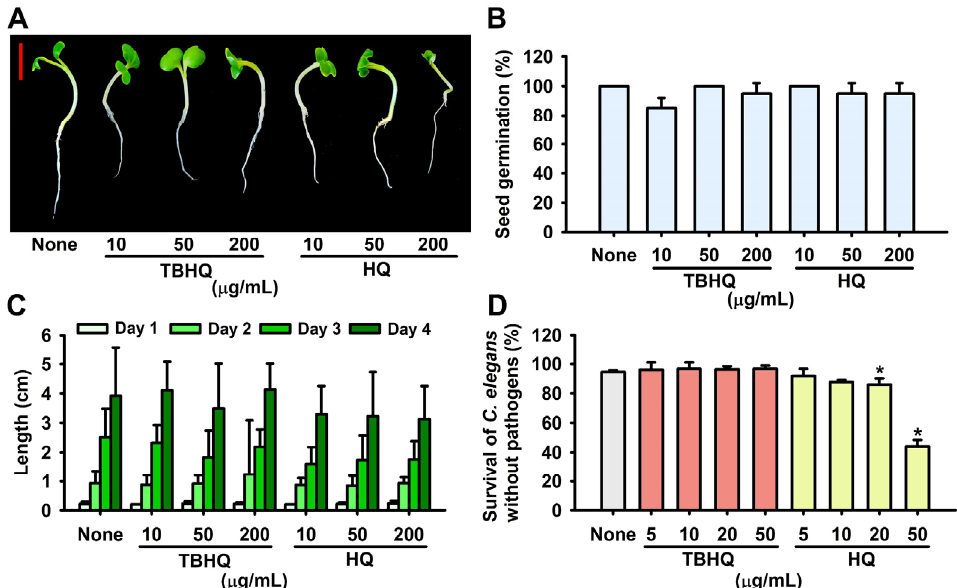
Figure 5. Toxicities of TBHQ and HQ in the plant and nematode models. B. rapa growth and seed germination was performed using Murashige and Skoog agar medium supplemented with or without TBHQ or HQ at 25 °C ( A ). Seed germination rates ( B ) and plant lengths ( C ) were measured over 4 days. C. elegans survival was assessed in the presence or absence of TBHQ or HQ after 4 days ( D ). * p < 0.05 vs. non-treated controls (None). The red scale bar represents 1 cm.